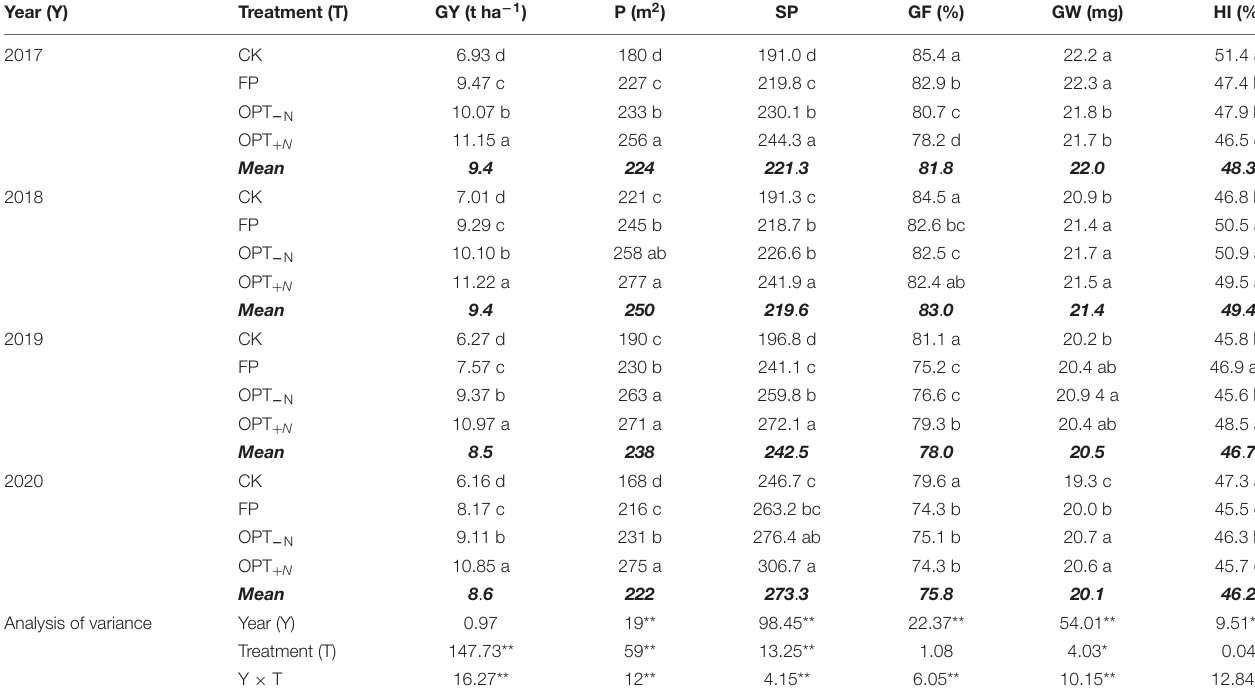
TABLE 2 | Grain yield (GY) and yield components at Jingzhou.